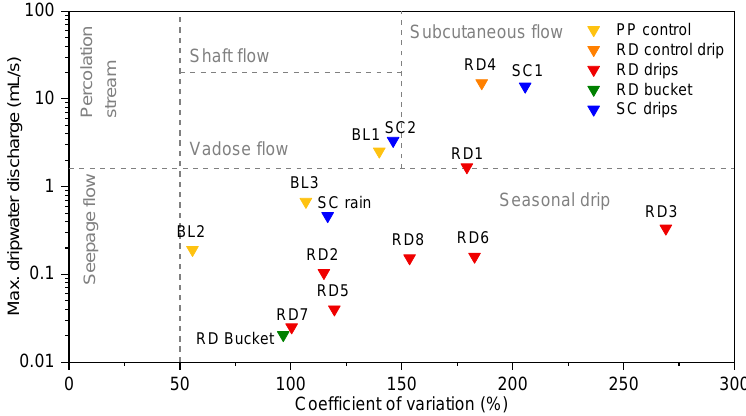
Figure 5. Classification of the drip spots based on manual measurements of the maximum drip discharges and their coefficients of variation following Baker et al. [45].